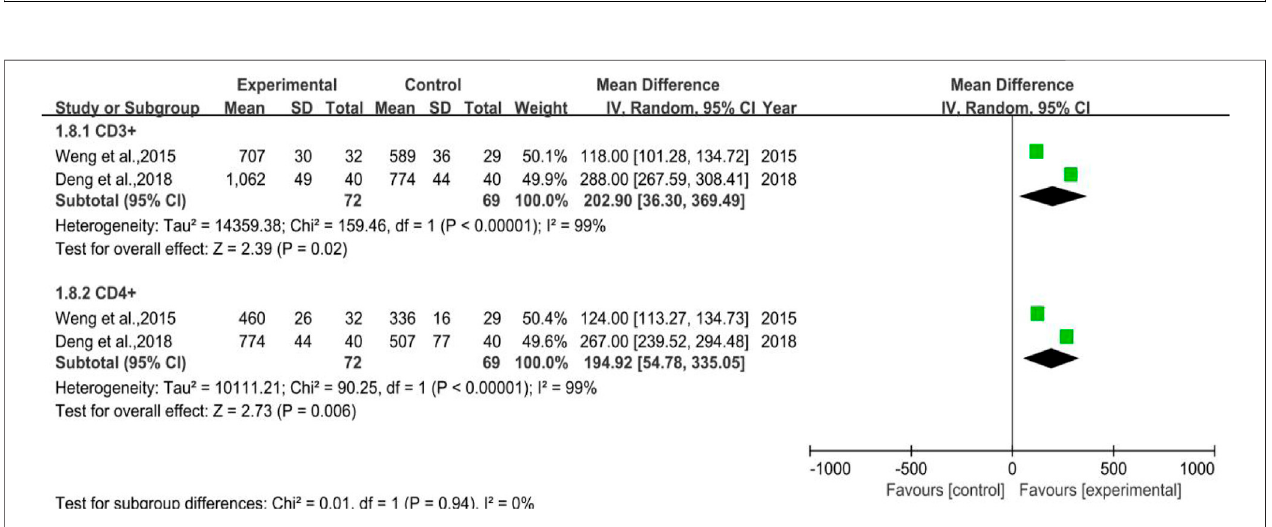
Frontiers in Pharmacology |